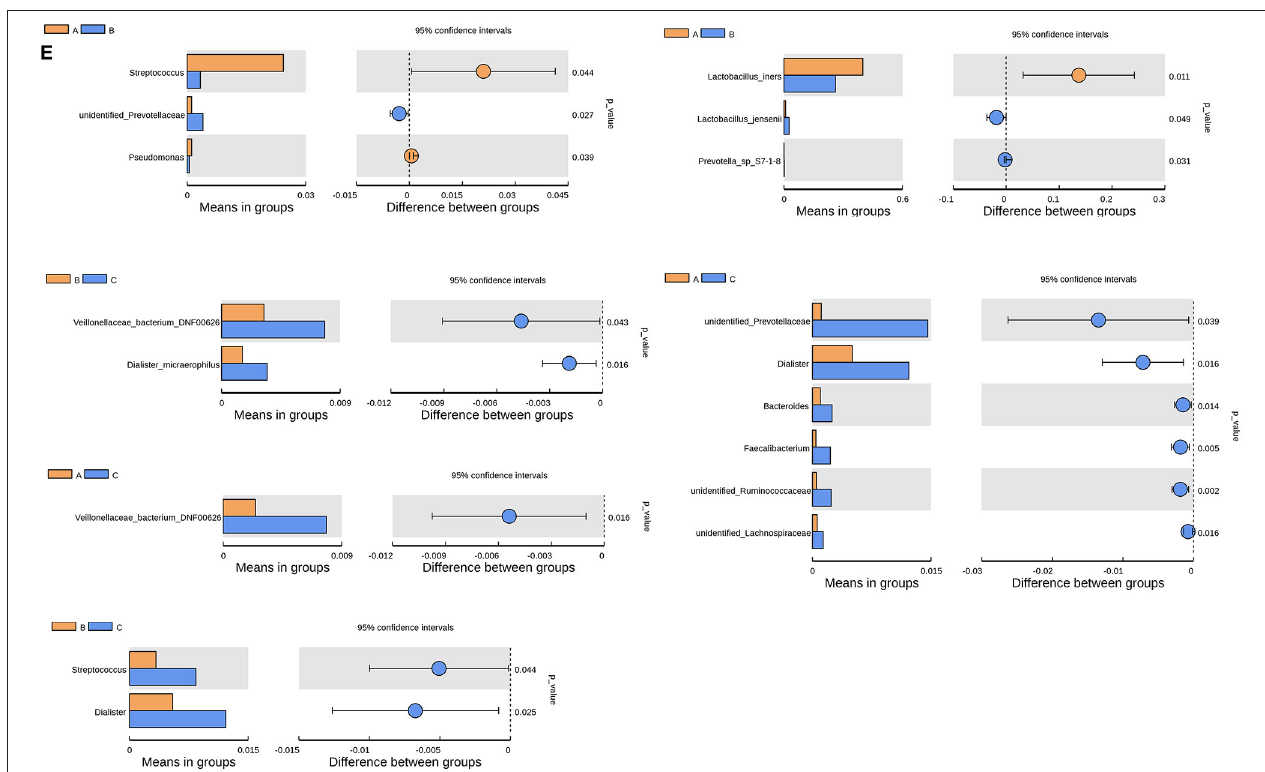
FIGURE 4 | Vaginal microbiome composition markers within three groups. (A) Distance Matrix Heatmap based on the weighted unifrac distance showing the intergroup difference within three groups. The number in the graph is the difference coefficient between two samples. The smaller the difference coefficient is, the smaller the difference of microbiome diversity is. (B) Bar chart of the comparisons of vaginal microbiota for intergroup difference analysis. (C) LEfSe identifies bacterial clades that are differentially abundant within three groups. Clades in this graph were both statistically significant ( P < 0.05) and had an LDA score > ± 4, considered a significant effect size. Prefixes represent abbreviations for taxonomic rank of each taxa: phylum (p_), class (c_), order (o_), family (f_), genus (g_), species (s_). (D) Significantly different abundance of bacterial clades within groups by MetaStat analysis. (E) Significantly different abundance of genera and species within groups by t -test